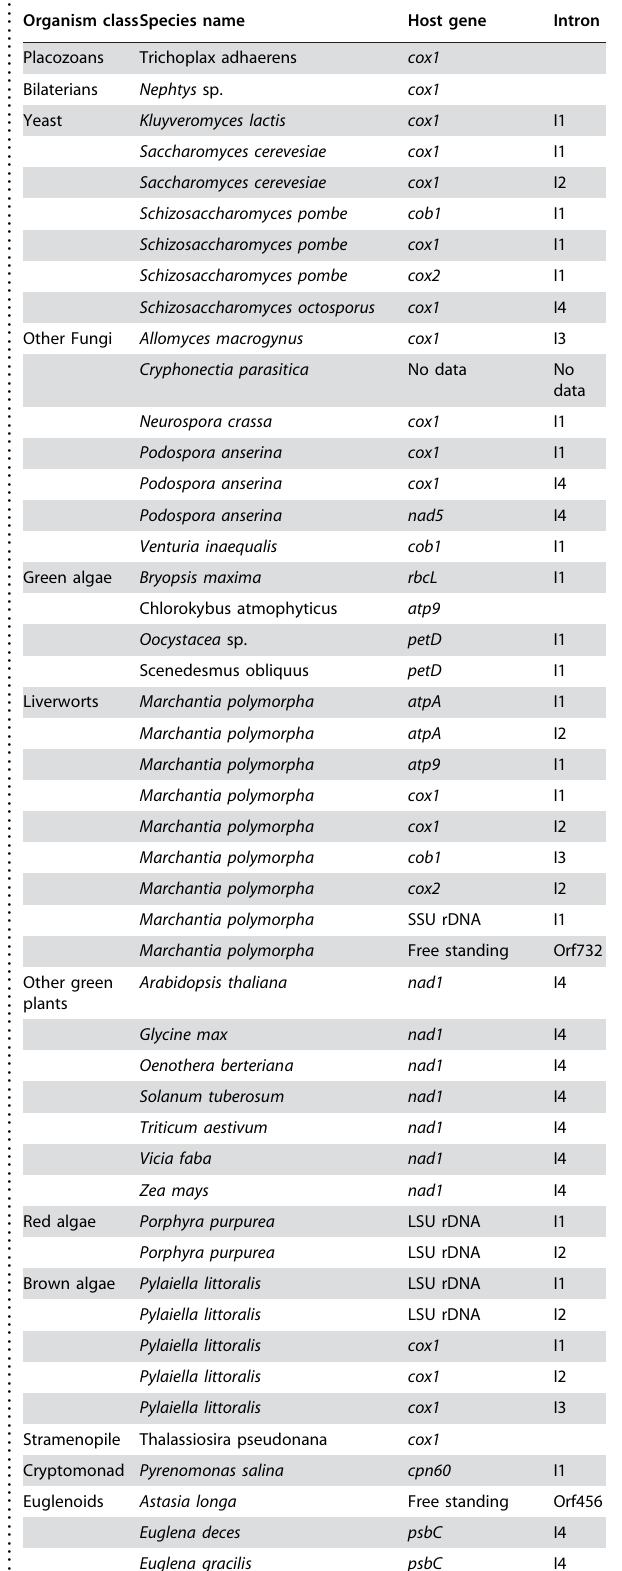
Organism classSpecies name